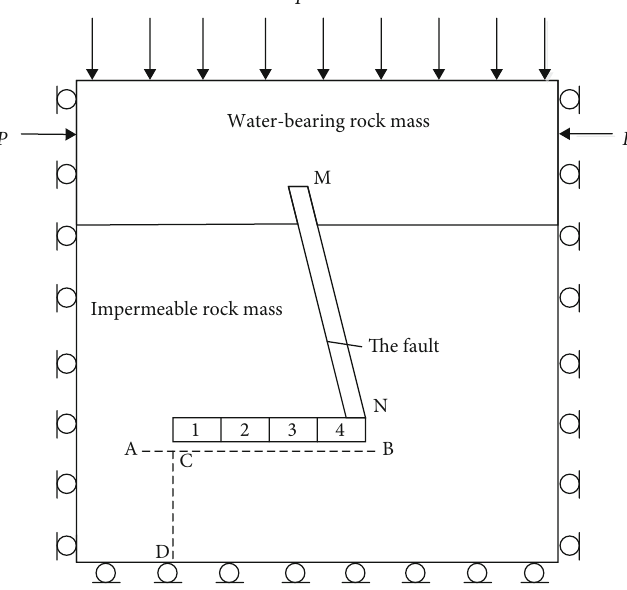
Figure 1: Numerical simulation model of tunnel excavation. Table 1: Mechanical parameters of rock